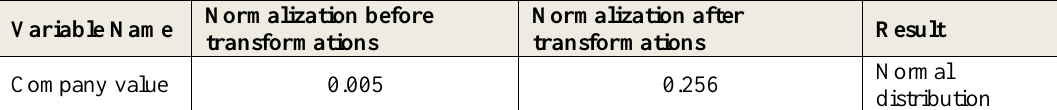
Table 6. The results of the Johnson transformation test for the dependent